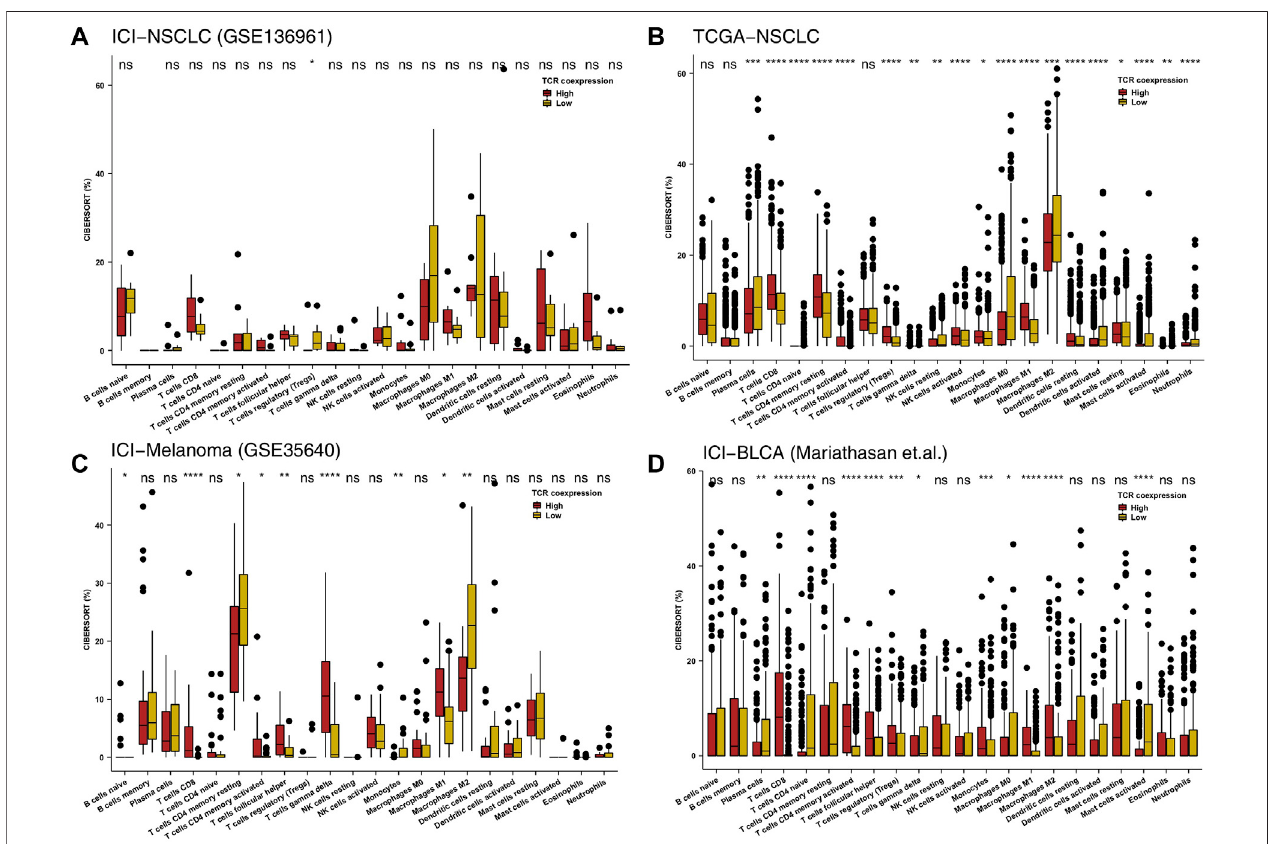
FIGURE 3 | High TCR coexpression signature was associated with a high proportion of activated immune cells. The 22 immune cell types estimated by CIBERSORT methods between the high- and low- TCR coexpression signature groups of the ICI-NSCLC (A) , TCGA-NSCLC (B) , ICI-Melanoma (GSE35640) (C) , and ICI-BLCA (Mariathasan et al.) (D) cohorts. The range of p -values is presented by the asterisks above each box plot (* p < 0.05; ** p < 0.01; *** p < 0.001; **** p < 0.0001; Mann-Whitney U test).